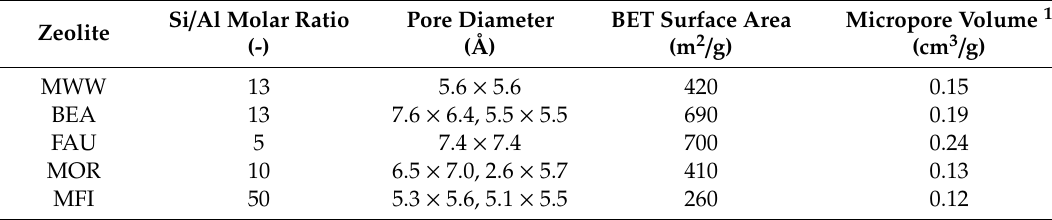
Table 1. Physical properties of the zeolite catalysts used in this work. Zeolite